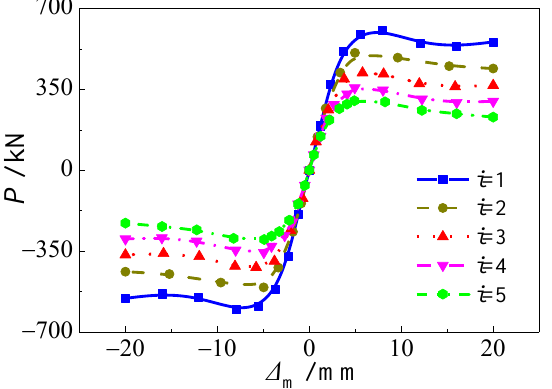
Figure 22. Effect of alternate times on skeleton curve.